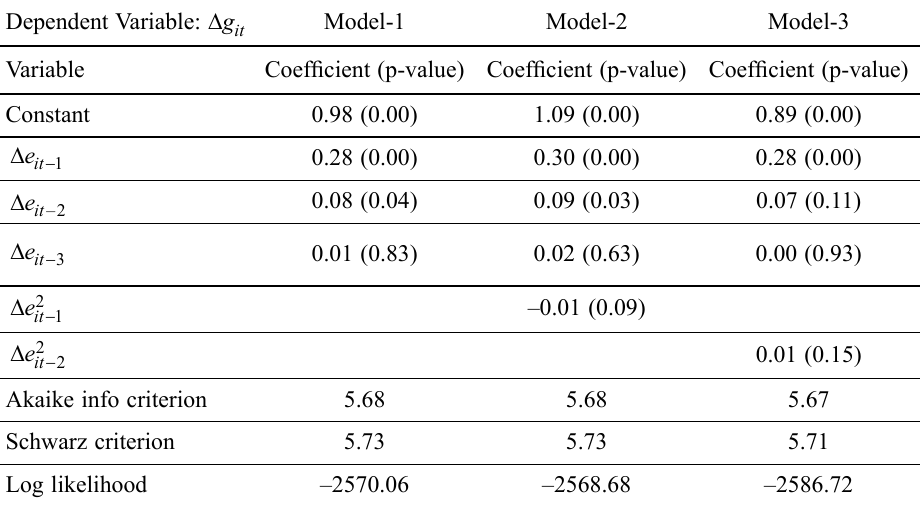
Table 3. Estimation result of the linear panel